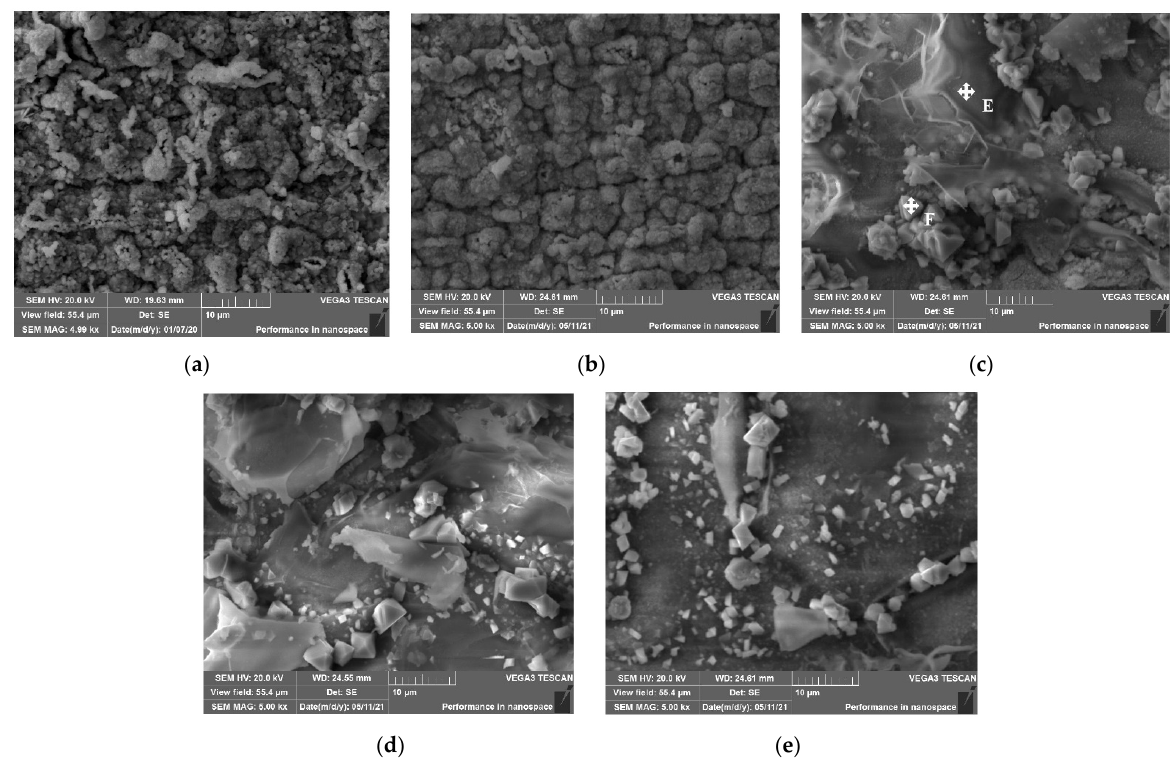
Figure 4. SEM surface morphology of samples uncoated and coated with different layers of mullite film after cyclic oxidation at 900 °C for 100 h: ( a ) uncoated; ( b ) single-layer; ( c ) three-layer; ( d ) six-layer; ( e ) nine-layer. Table 4. EDS analysis results of the sample with different-layer of mullite film after oxidation.